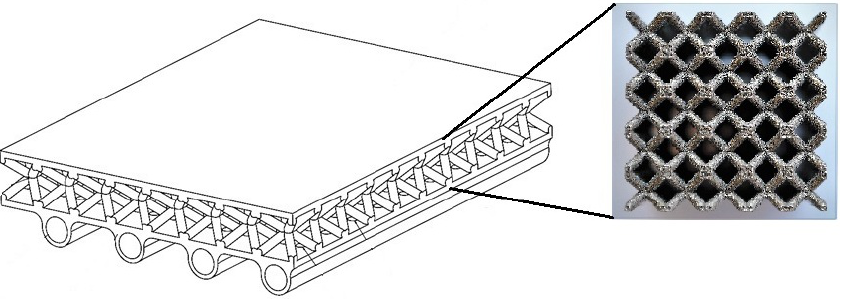
Figure 2. Section of the panel.